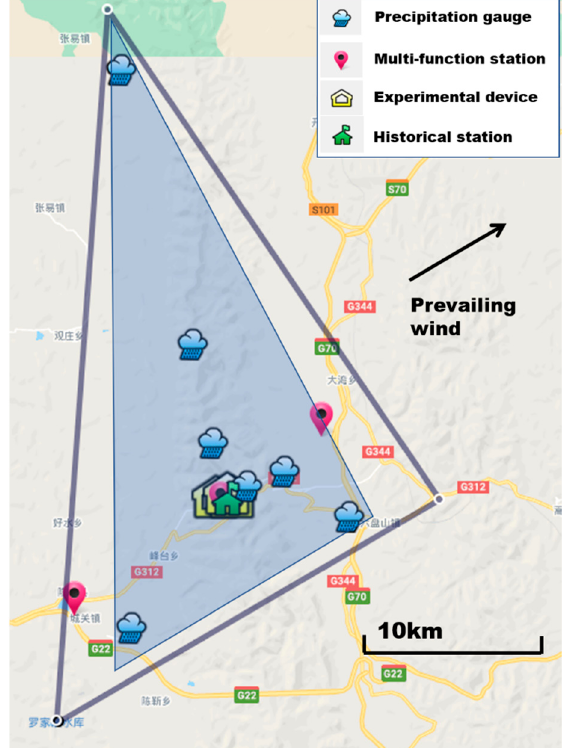
Figure 3. Satellite picture of Liupan Mountain area. Locations and construction of the sites are shown in Figure 4.